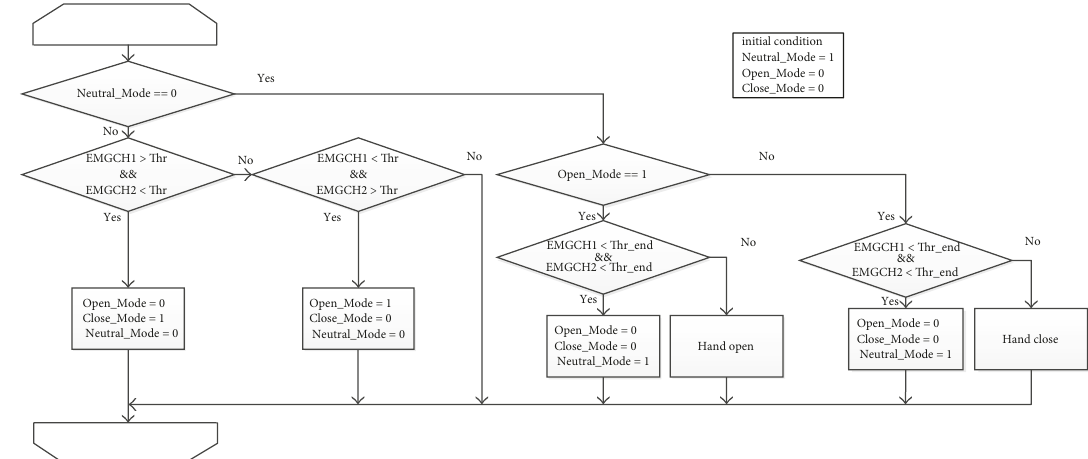
Figure 4: Flowchart of hand open/close. “Thr” and “Thr end” are threshold value to control of the prosthetic hand opening and closing.